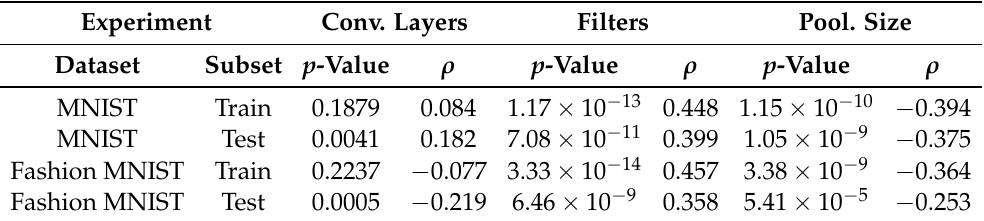
Table 3. Spearman’s correlation test between number of convolutional layers/number of filters/size of pooling layers and categorical accuracy for each experiment.